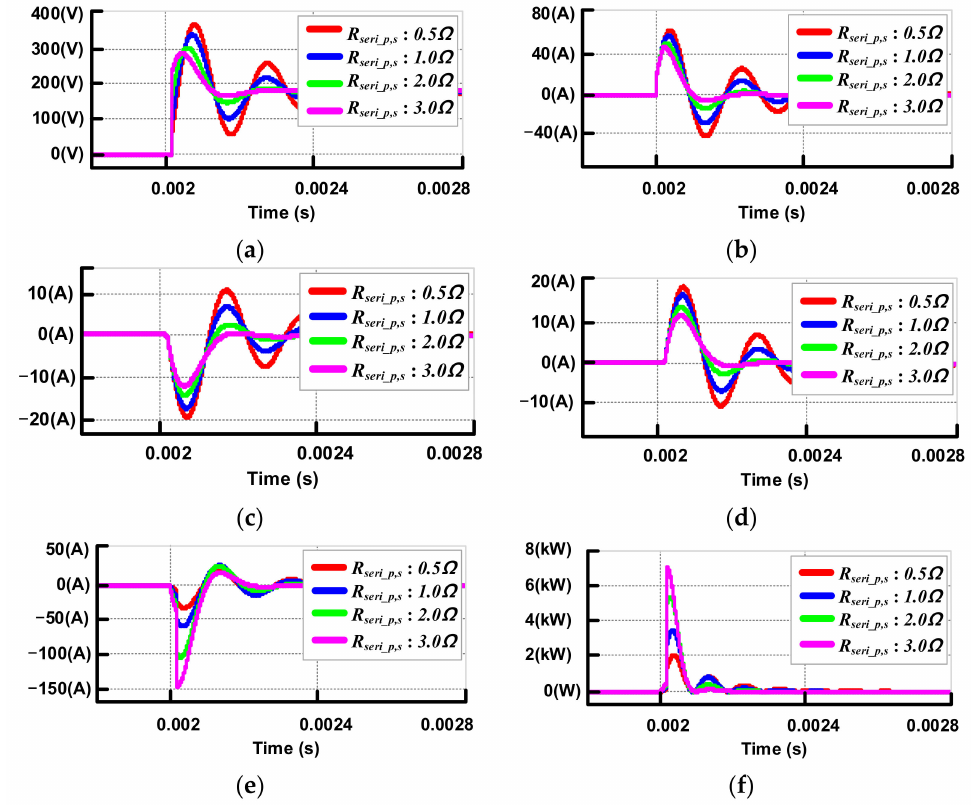
Figure 6. Simulation waveforms for different series resistor values: ( a ) voltage across main switch, ( b ) fault current, ( c ) current in primary winding, ( d ) current in secondary winding, ( e ) current of parallel resistor linked to secondary winding, and ( f ) power burden of series resistor linked to secondary winding.